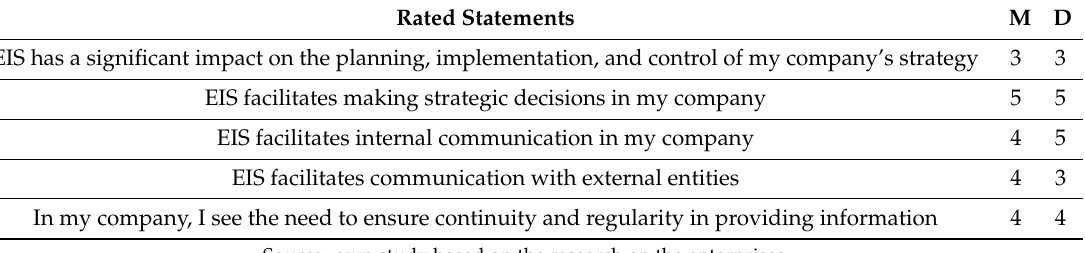
Table 2. Impact of the enterprise information system on selected areas (n = 70).